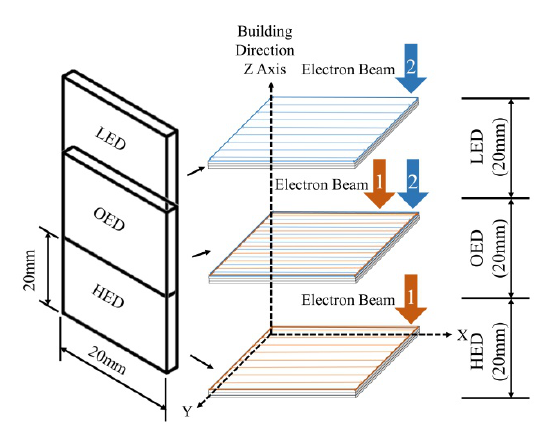
Figure 2. Schematic of SEBAMed samples made by higher, lower and overlap energy density from the bottom to top which labeled as high energy density (HED), overlap energy density (OED) and low energy density (LED) along build direction fabricated by electron beam additive manufacture. HED, LED built zones independently 26.5 and 16 J / mm 3 . OED built zone in 26.5 J / mm 3 first and build sequentially 16 J / mm 3 .